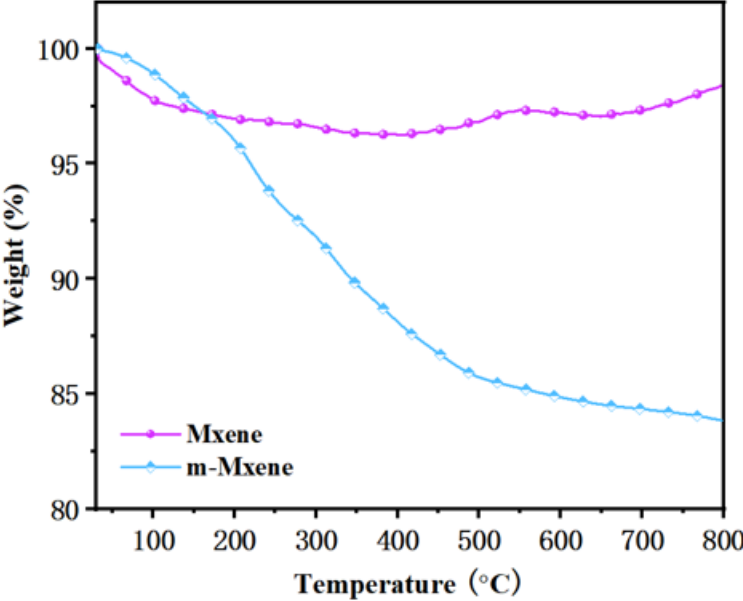
Figure 4. TGA plots of MXene and m-MXene under nitrogen.